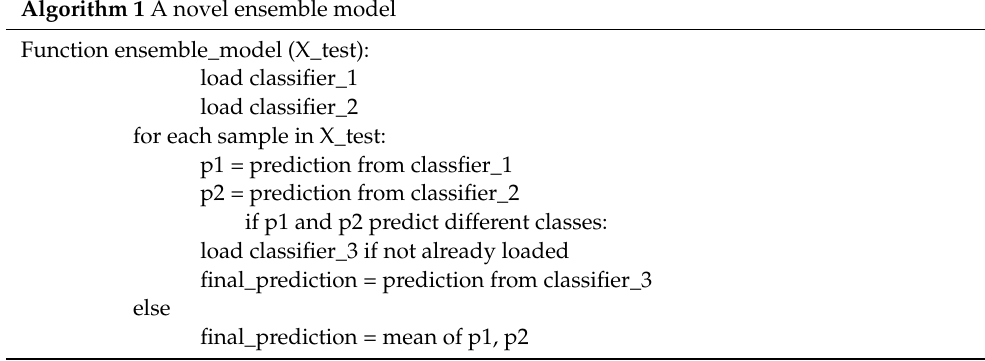
Algorithm 1 A novel ensemble model